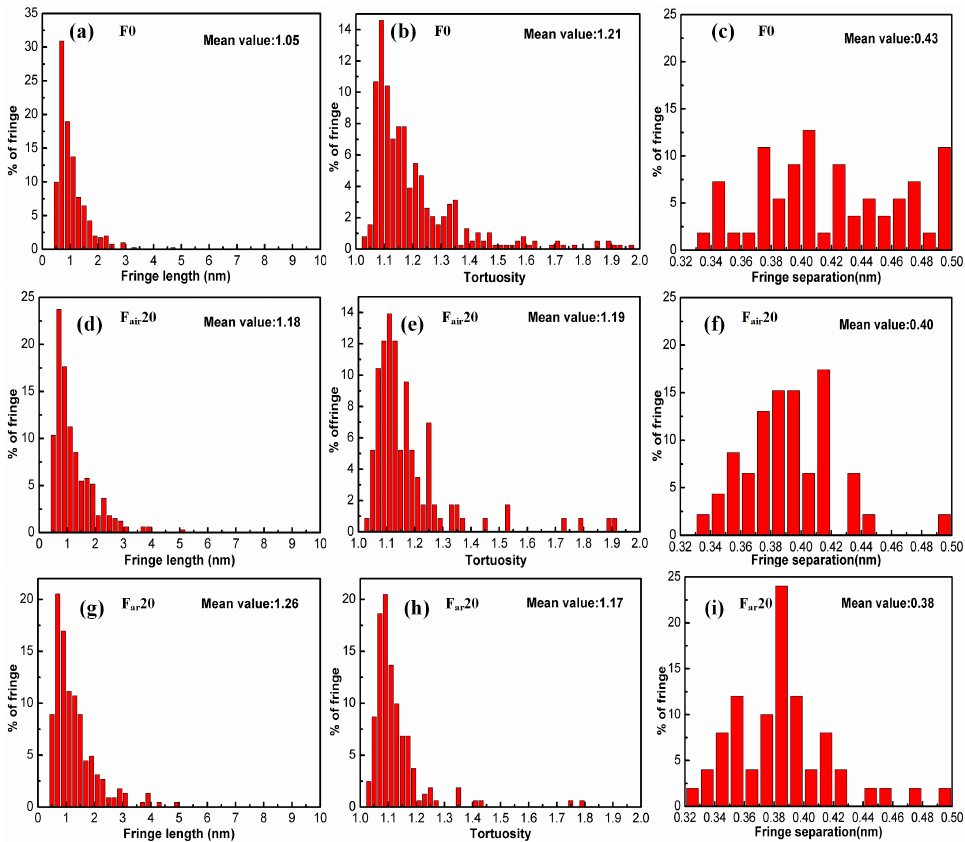
Figure 5. Histograms of fringe length, tortuosity and separation for F0, F air 20 and F ar 20 derived from the corresponding skeleton images: ( a ) Histograms of fringe length for F0; ( b ) Histograms of tortuosity for F0; ( c ) Histograms of separation for F0; ( d ) Histograms of fringe length for Fair20; ( e ) Histograms of tortuosity for Fair20; ( f ) Histograms of separation for Fair20; ( g ) Histograms of fringe length for Far20; ( h ) Histograms of tortuosity for Far20; ( i ) Histograms of separation for Far20.